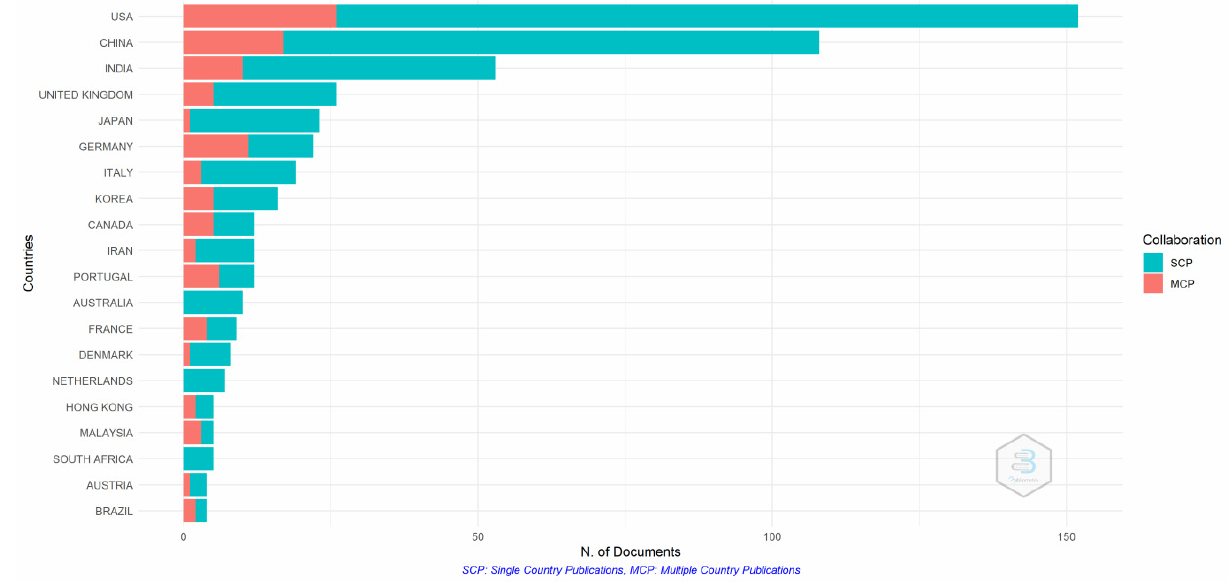
Figure 7. Authors’ countries. Source: Authors’ elaboration using the Bibliometrix R-package.